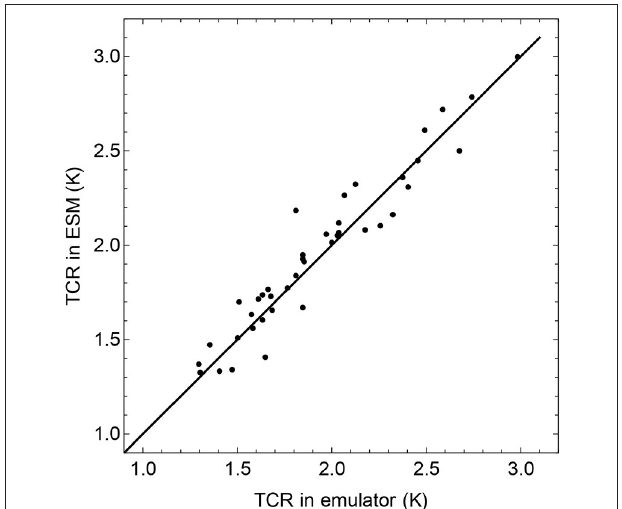
FIGURE 3 | Comparison of TCR estimated from the 1% per year experiments in 41 ESMs and the TCR estimated in the corresponding emulators. The figure shows that the computed climate response using the discretization in Equation (2) is unbiased when using the midpoint rule, i.e., δ = 0.5 yrs.